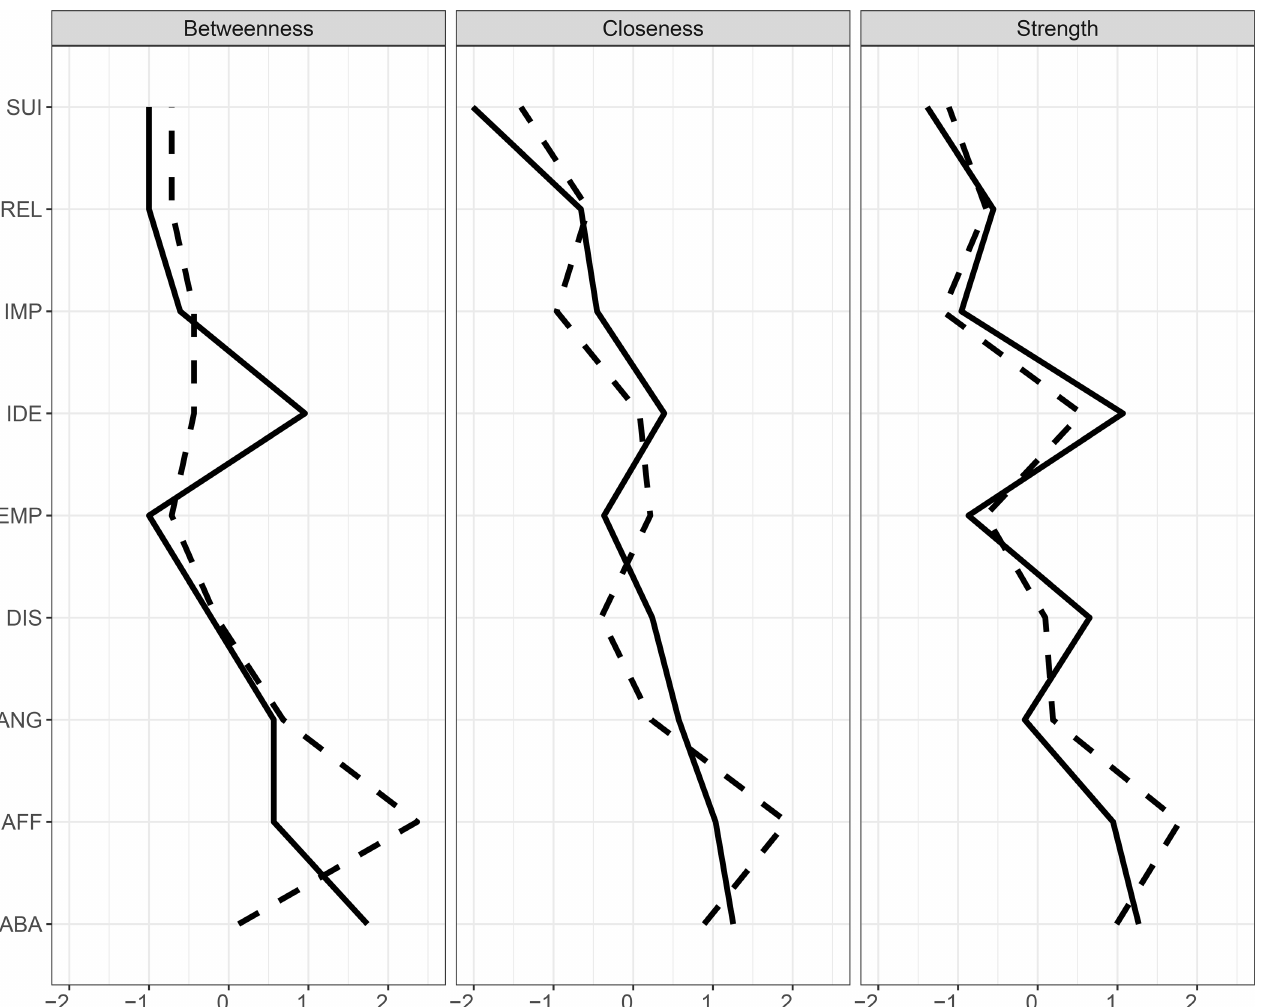
Fig 2. Nodes centralities for each of the nine symptoms of Borderline Personality Disorder for the student (full lines) and clinical (dashed lines) samples. ABA: Efforts to avoid abandonment, REL: UnstableRelationships, IDE: Identity disturbance, IMP: Impulsivity, SUI: Suicidaland para-suicidal behavior,AFF: Affective Instability, EMP: Chronicfeelingsof emptiness,ANG: Difficulty controllinganger, DIS: Dissociation and paranoidideation.For ease of comparisonfor Fig 2, centrality values were standardized (z-scored) in each sample (see Table in S4 Table for exact